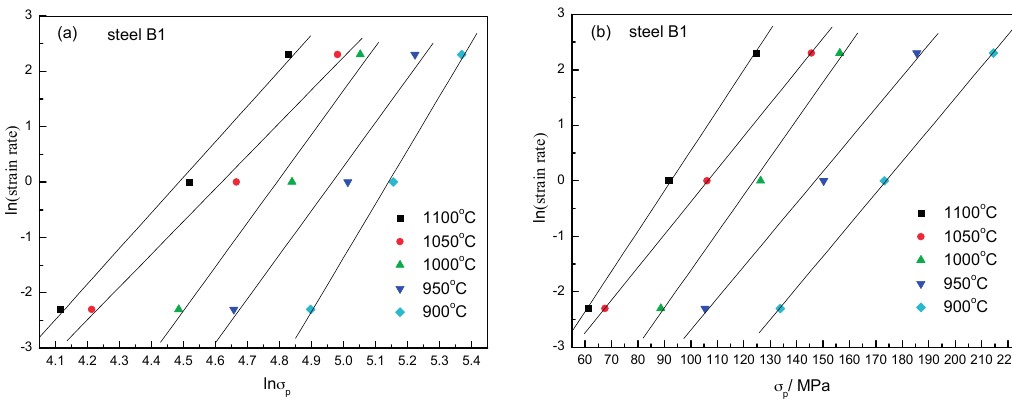
Figure 6. Relationship between ln(strain rate) and ( a ) ln σ p ; ( b ) σ p